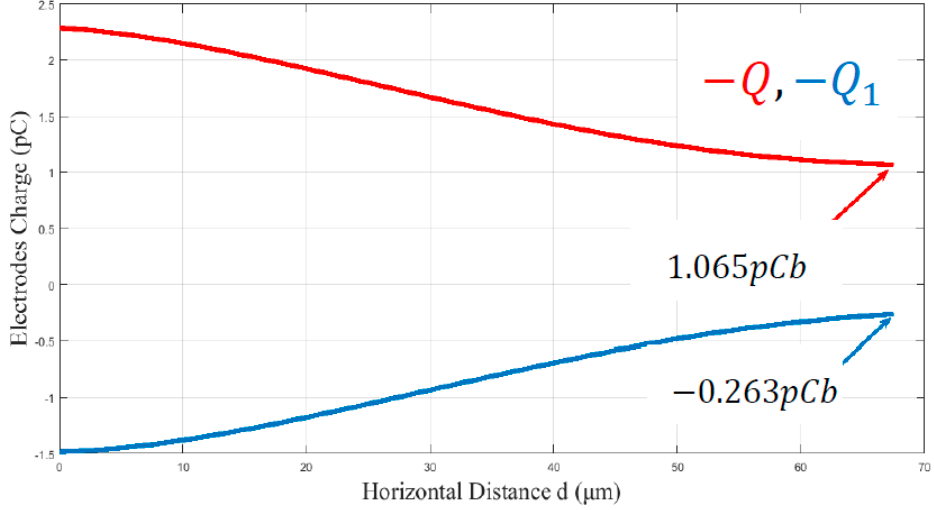
Figure 6. Comparing the Charge of platform and Micropart electrodes with respect to their centers distance—Platform Electrode—Micropart Electrode.